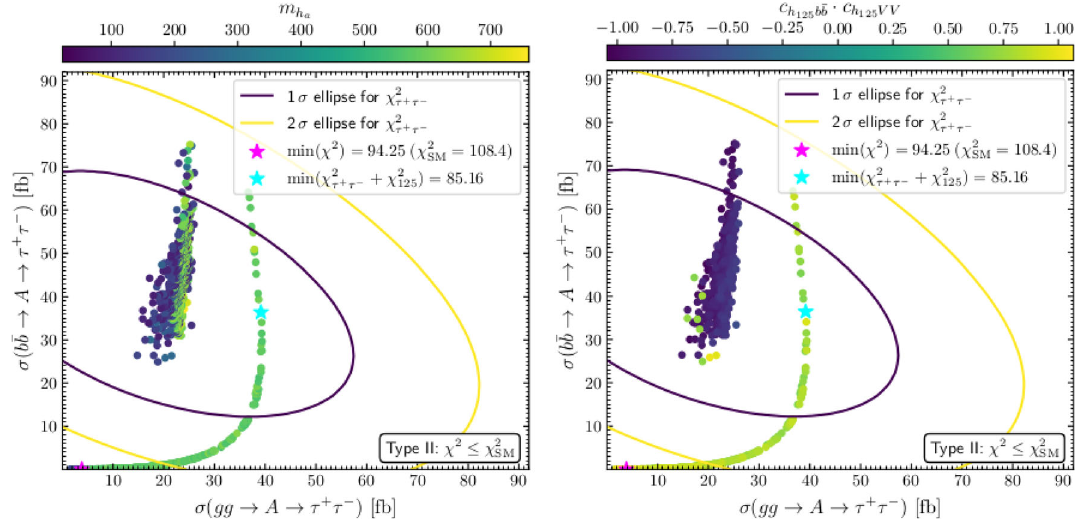
Fig. 4 Signal cross sections of A → τ + τ − for the gg production mode on the horizontal axis and the b ¯ b production mode on the verti- cal axis. The colors of the points indicate the value of m h · c c h 125 VV (right). The dark blue and the yellow lines indicate the h 125 b ¯ b